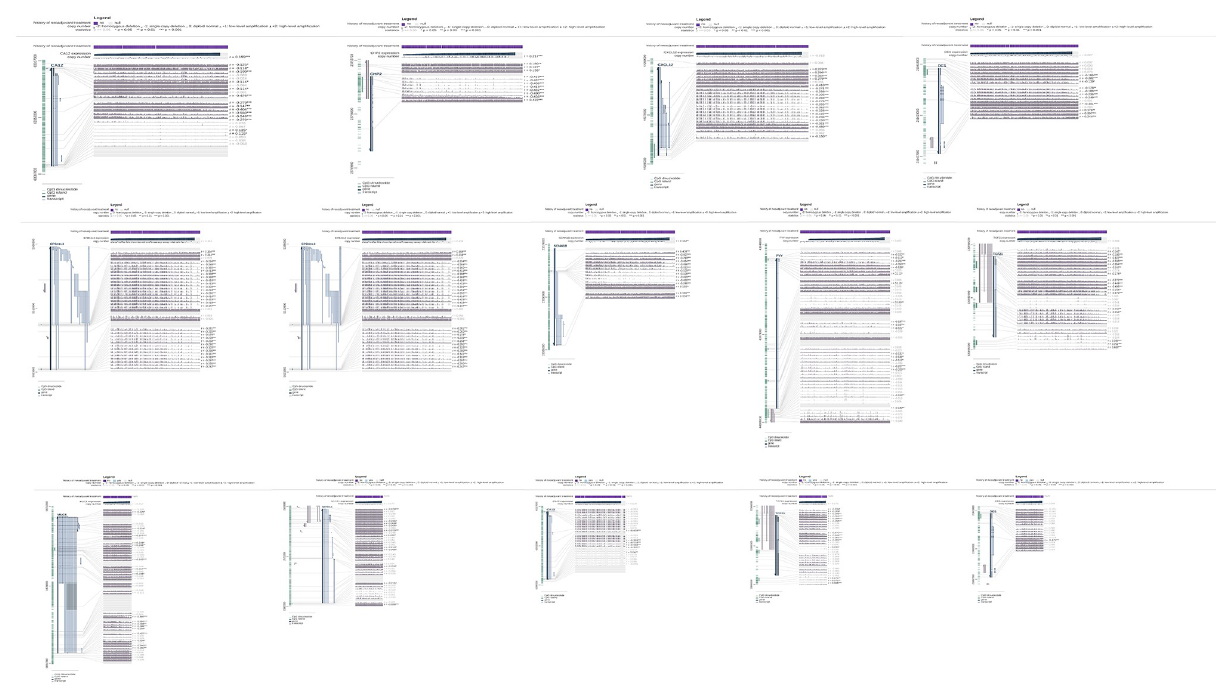
Fig 8. MEXPRESS results of statistically significant under-expressed/hyper-methylated validated Differentially Expressed Genes-Differentially Methylated Genes (vDEGs-DMGs). The first nine results pertain to COAD cancer type and the last five results correspond to READ cancer type.